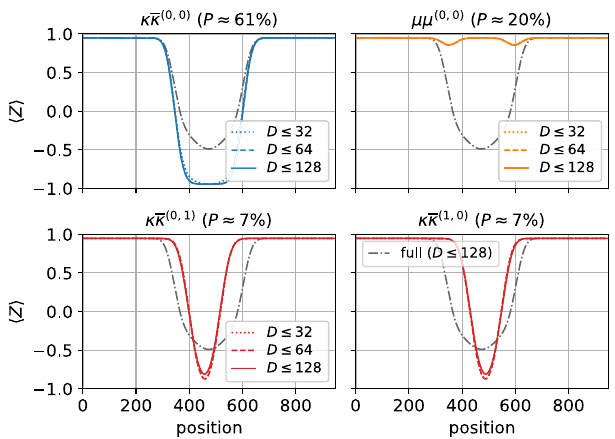
FIG. 10. Spin expectation values, after projecting into selected quasiparticle subspaces and normalizing, for simulation (ii) of Fig. 7, bond dimension D ≤ 128, after the first collision ( t ≈ 426). The amount of wavefunction captured by each